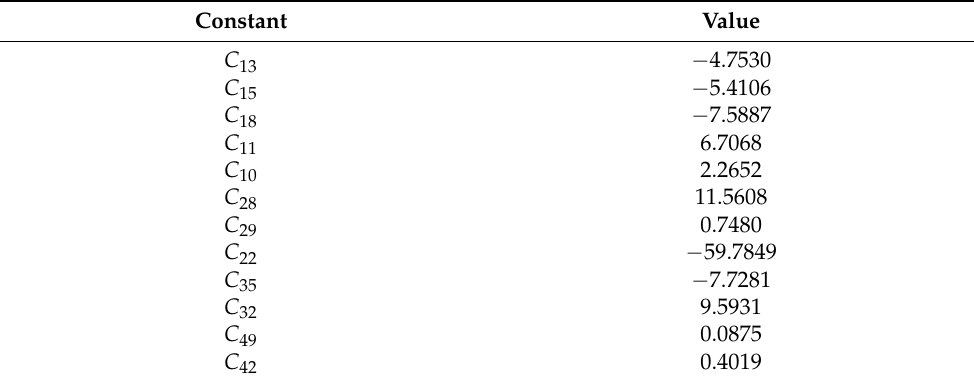
Table 7. The constant values obtained for Equations